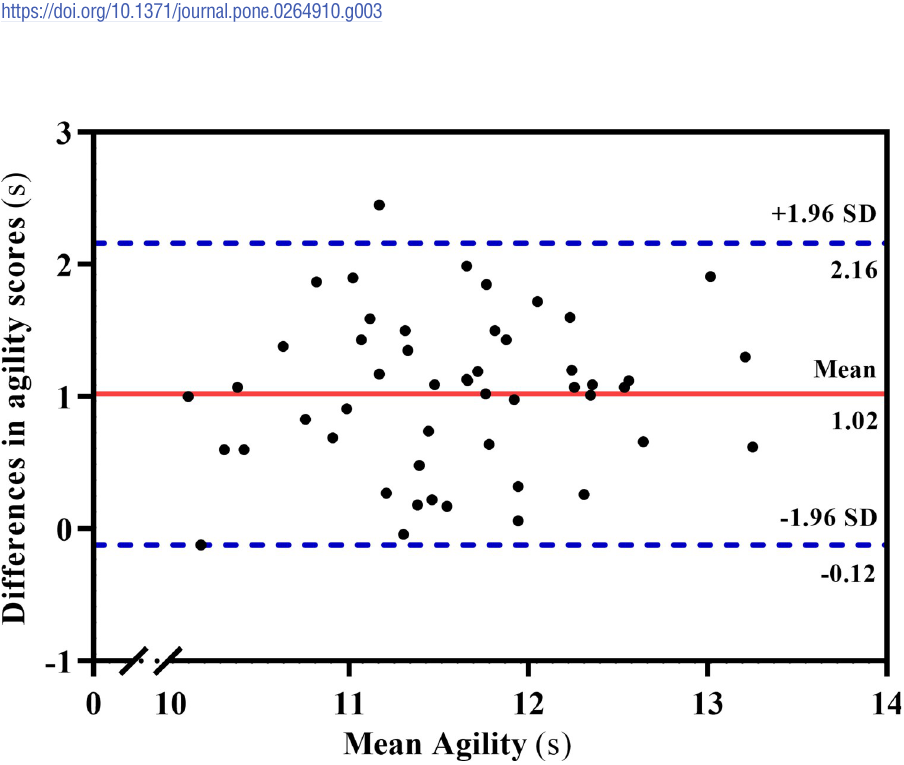
Fig 4. Bland-Altman plot for comparison between the agility T-Test and the agility function of taekwondo- specific aerobic-anaerobic-agility (TAAA) test.